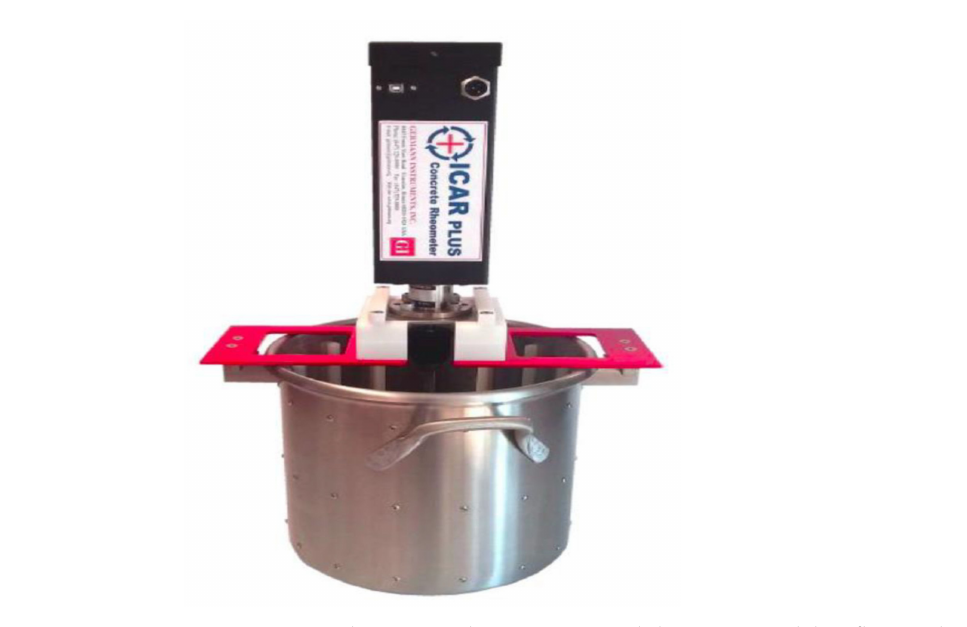
Figure 5. ICAR rheometer. The parameter and rheometer models influence this equation.